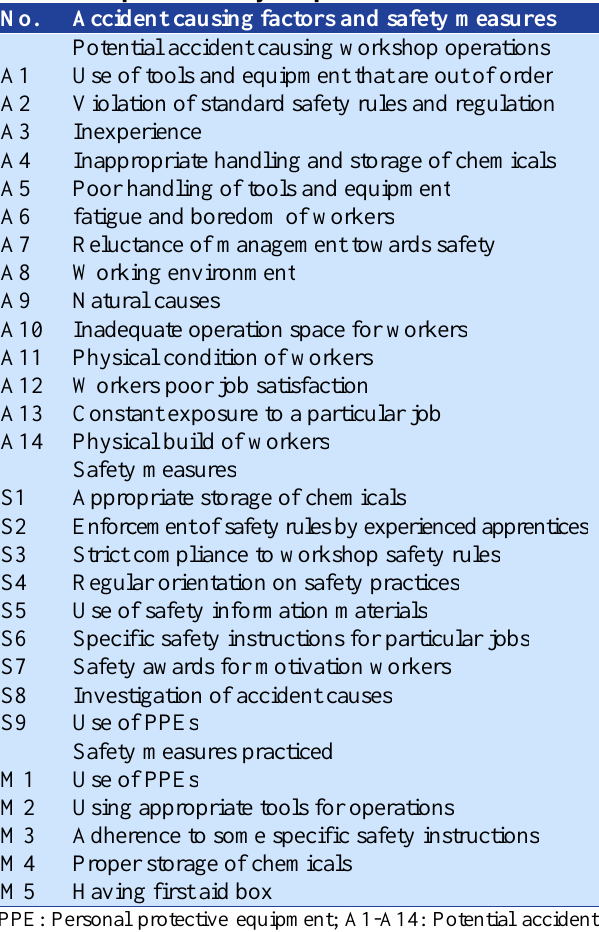
Table 1. Potential accident causing